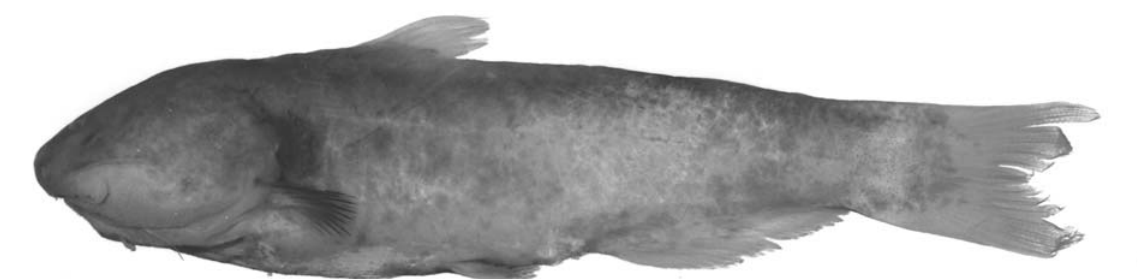
Fig. 35 . Cetopsis parma , holotype, MUSM 2266, 73 mm SL; Peru, Ucayali, Provincia Coronel Portillo, río Tambo, Pucallpa, Atalaya (8°23’S,